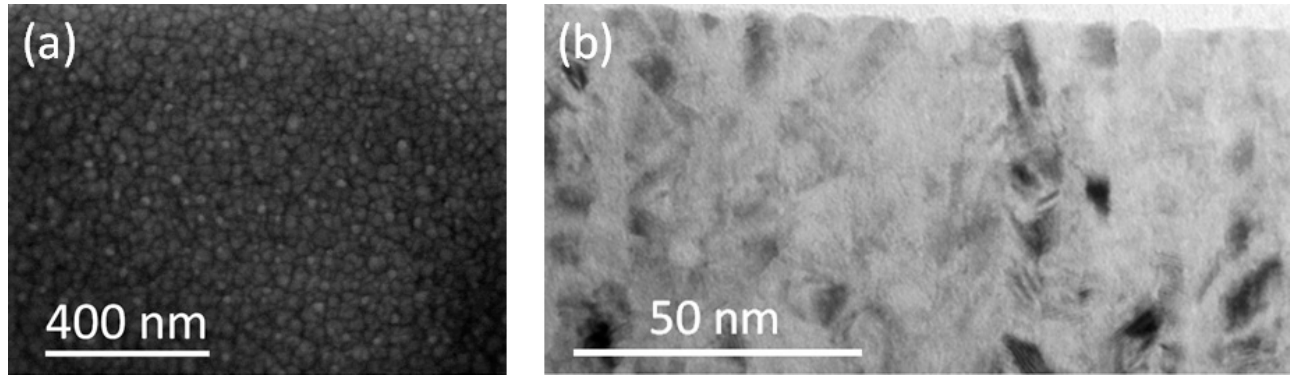
Figure 2. SEM morphology of the free surface ( a ) and TEM cross-sectional image ( b ) of FeNi film of 100 nm thickness.